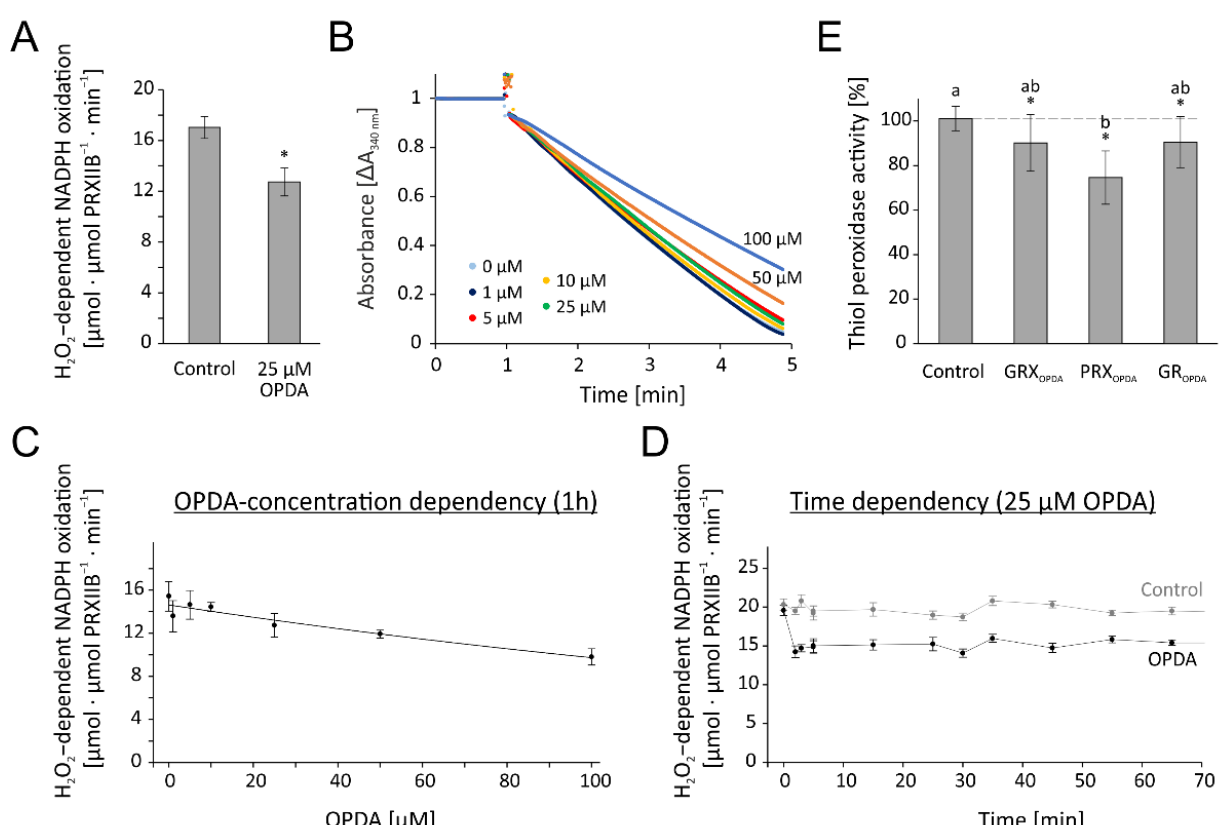
Figure 9. OPDA effect on peroxiredoxin IIB-dependent peroxide detoxification using the reconstituted system. ( A ) Effect of 25 µ M OPDA on GRXC2-dependent PRXIIB activity. The reaction mix was incubated for 1 h. The assay was performed with 200 µ M NADPH, 2 mM glutathione, 1 µ M GR, 0.25 µ M GRXC2, 3 µ M PRXIIB and 300 µ M H 2 O 2 . Data are means ± SD of n = 6. Significance of difference was determined using t-test ( p = 0.0013) and is marked with *. ( B ) Representative absorbance recordings adjusted to the identical time point of H 2 O 2 addition and similar baselines. The reaction started by the addition of 300 µ M H 2 O 2 at t = 1 min. The tests were performed